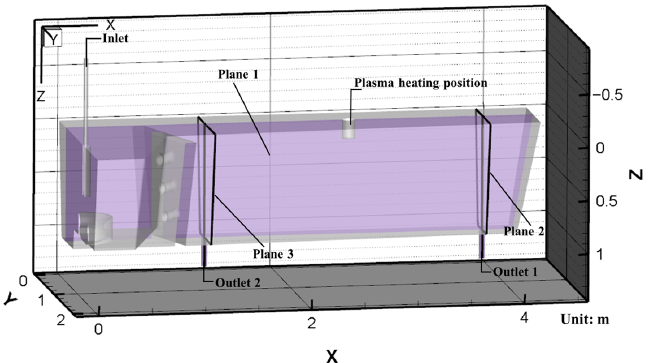
Figure 1. Schematic diagram of tundish plasma heating.